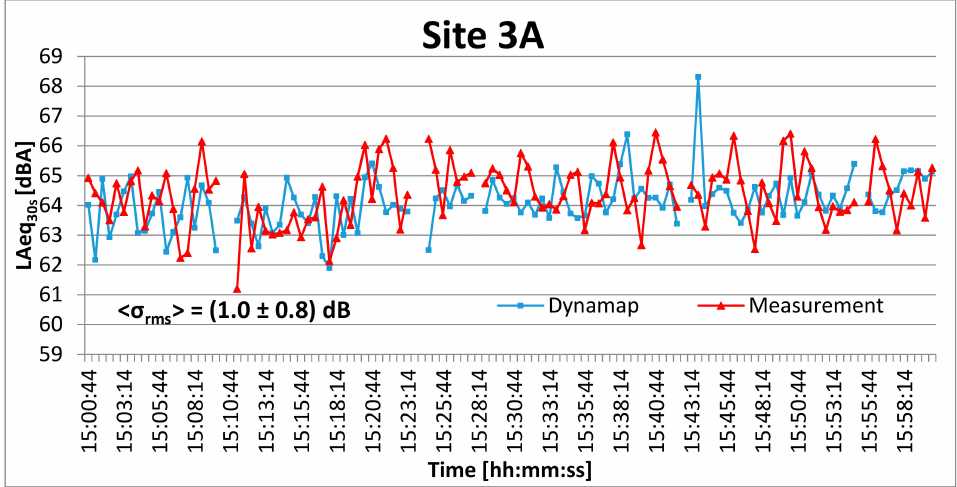
Figure 14. Comparison between DYNAMAP prediction (blue line) and measurement (red line)